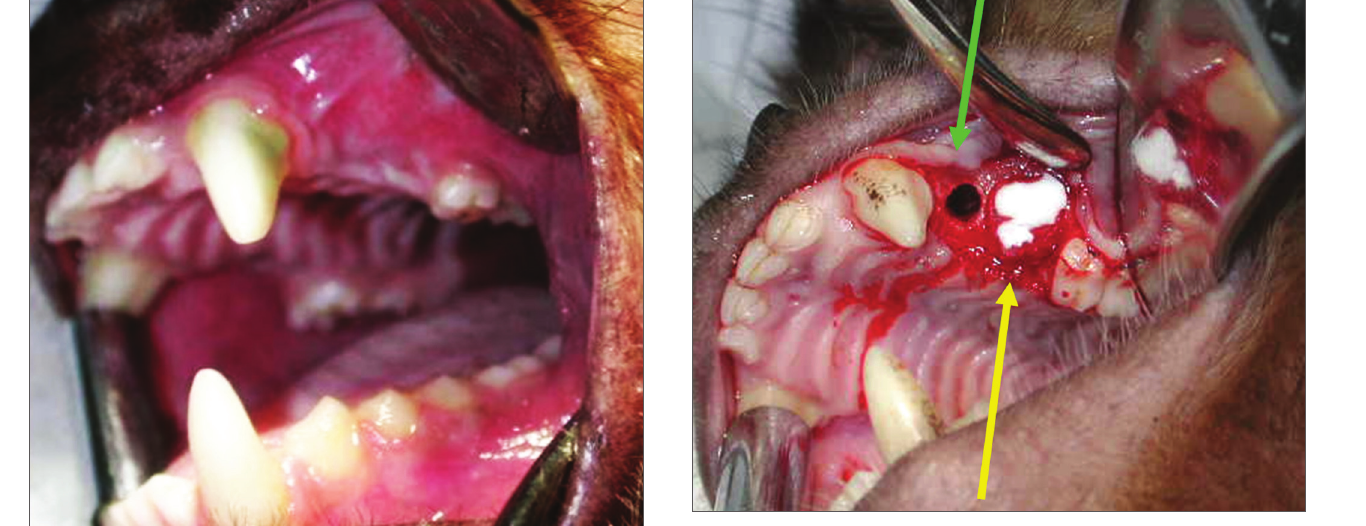
Figure 4. Control surgical defect (green arrow); Surgical defect with a collagen membrane (yellow arrow).